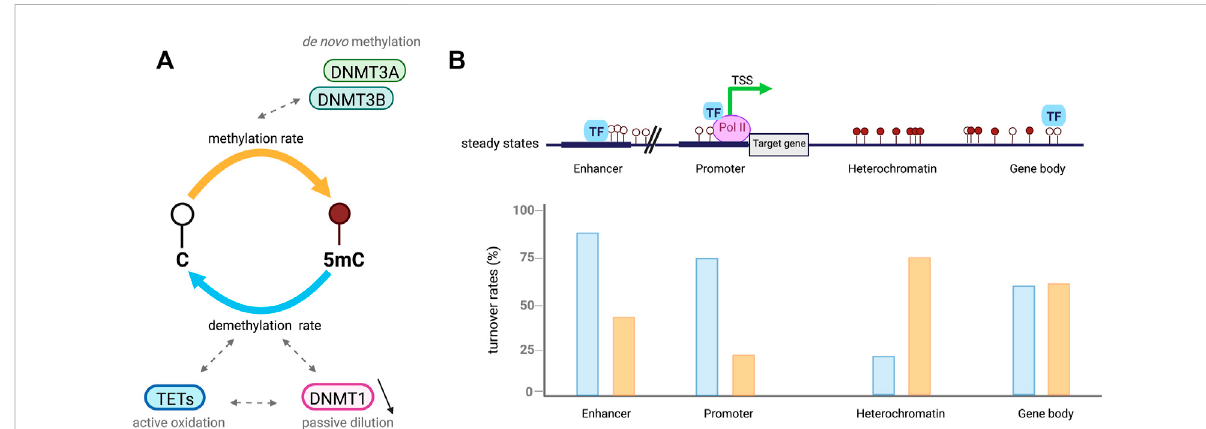
Cytosines undergo dynamic methylation turnover. (A) . In a cell population, steady-state DNA methylation is reached when overall DNA methylationrates(orange)areequivalenttodemethylationones(blue).Givenanidenticalsteady-state,CpGsarein fl uencedbydifferentmethylation ( de novo ) and demethylation (active oxidation and passive dilution) rate combinations called DNA methylation turnover. (B) . Example of DNA methylation turnover depending on CpGs location in the genome, based on Ginno et al. (2020). In euchromatic context, CpGs at regulatory regions including enhancers and promoters present low steady-state DNA methylation levels associated with increased demethylation rates (blue) compared to methylation ones (orange). High rates of passive demethylation are observed at promoters while active demethylation is more important at enhancers. CpGs in heterochromatic regions have high steady-state methylation which tends to be associated with low DNA methylation turnover. However, CpGs located at gene bodies are also highly methylated but tend to have a higher